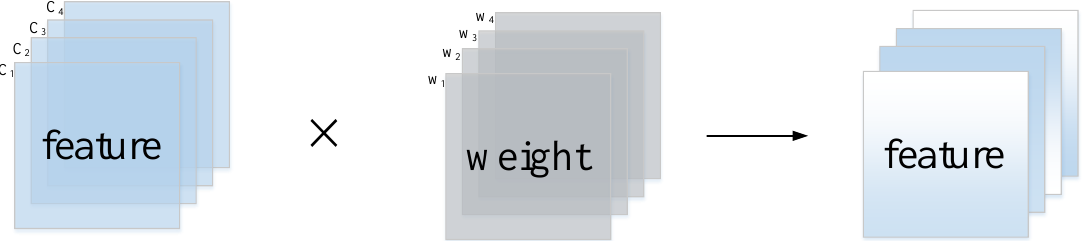
Figure 6. MaskFPN suppression of feature information. The white part of the feature map represents the semantic information filtered by MaskFPN.